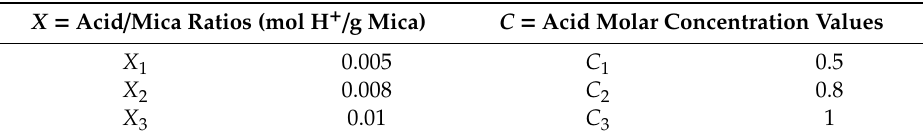
Table 2. X Acid / Mica and Acid Molar Concentration Table 2. X Acid/Mica and Acid Molar Concentration Values